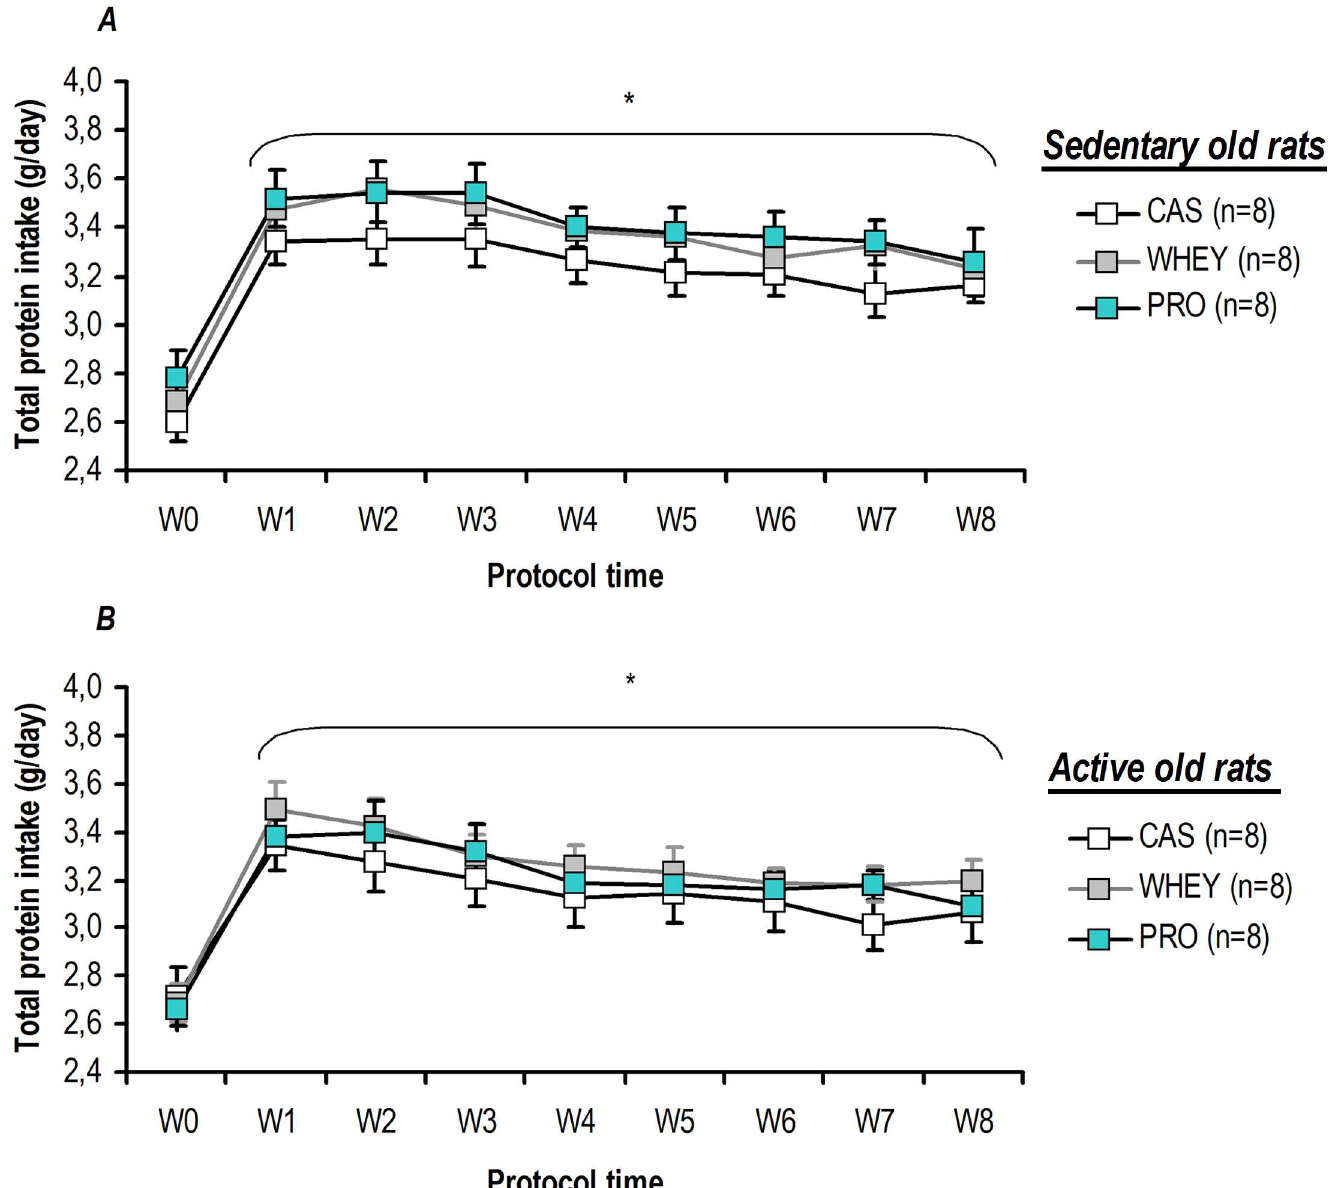
Fig 2. Protein supplementation without food deprivation induced a significant and enduring increasein total protein intake. For sedentary ( A ) and active ( B ) old rats, supplementation significantly increasedthe total protein intake ( i . e food and specific proteins) over the course of the study period. For each analysedtime point, there was an equal amount of total protein ingested,regardlessof the specific protein being tested. Values are means ± SEM. W0 to W8: weeks of protocol with W0 being the week prior to physicalactivity and/or protein supplementation. * p < 0.05 vs .